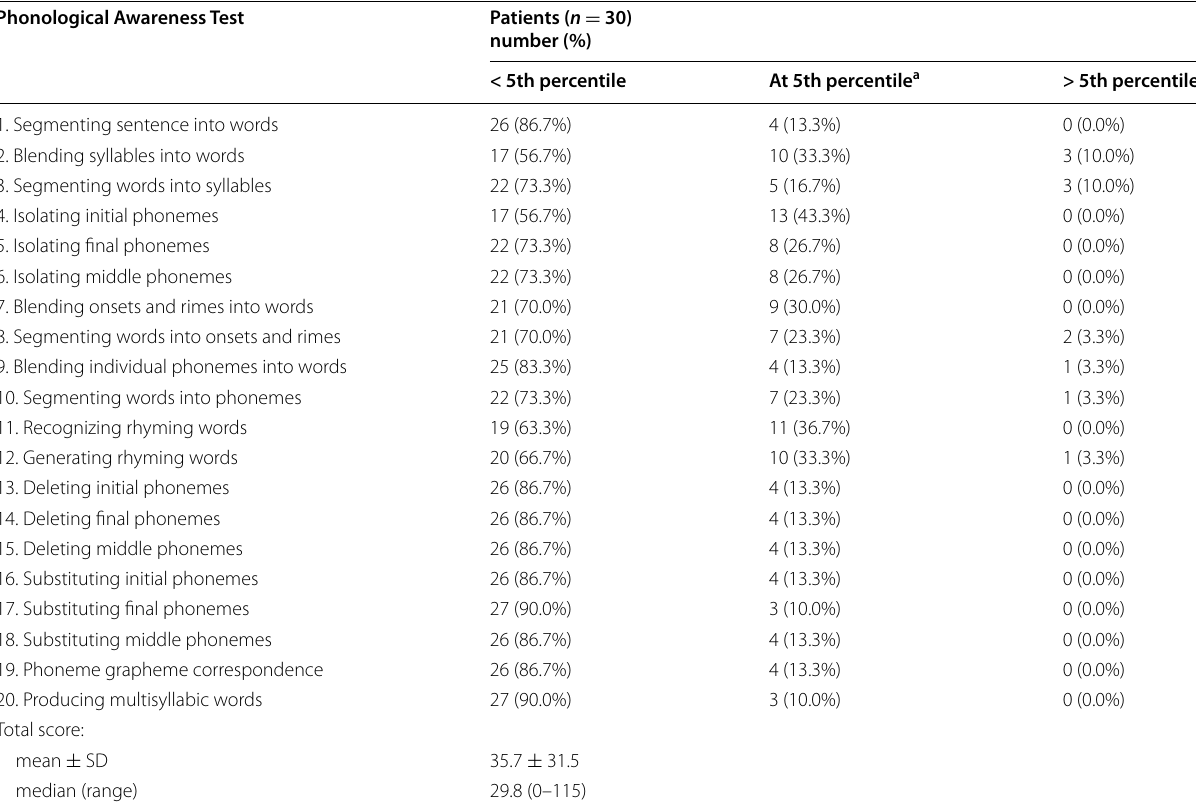
Table 2 Results of the Phonological Awareness Test